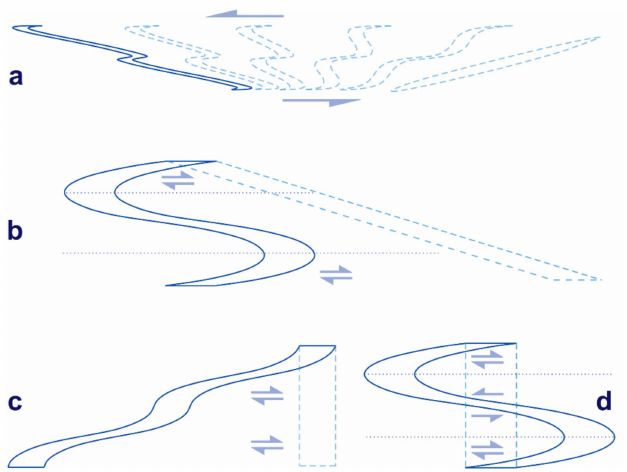
Figure 8. Four different models of folding create asymmetric folds that show opposite vergence of the sense of shear: ( a ) Increasing strain (to the left in this figure) when the initial layer is at a low angle to axial plane in simple shear folding [81,82]; ( b ) Initial layer at a low angle to axial plane, heterogeneous simple shear with a constant sense of shear parallel to the axial plane [83]; ( c ) Initial layer at a right angle to axial plane, asymmetric folds produced by heterogeneous simple shear with a constant sense of shear parallel to the axial plane [79]; ( d ) Initial layer at a right angle to axial plane, heterogeneous simple shear parallel to axial plane, reversal of shear sense across axial plane